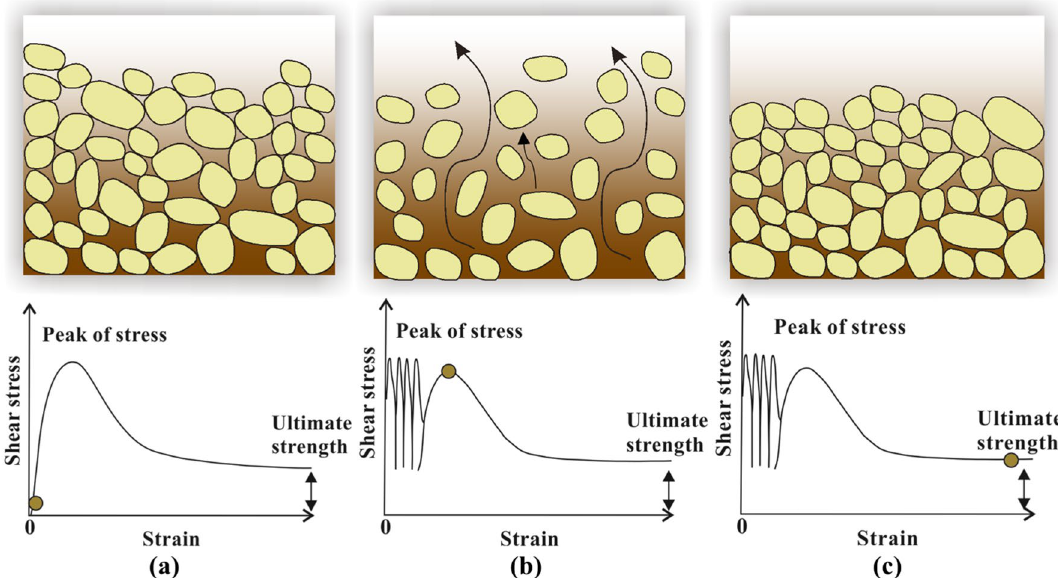
Fig. 9 Liquefaction process. The orange dot on the stress ‒ strain curve indicates the stage of the process illustrated in the diagram above: a a potentially liquefiable sandy deposit and a hypothetical shear stress/strain curve; b sediment during the liquefaction process; and c following the earthquake and liquefaction, grains re-establish their intergrain contacts (rebuilding their effective stress), where σ´ is the total stress, σ is the effective stress and u is the pore-water pressure (modified from Bucci et al.